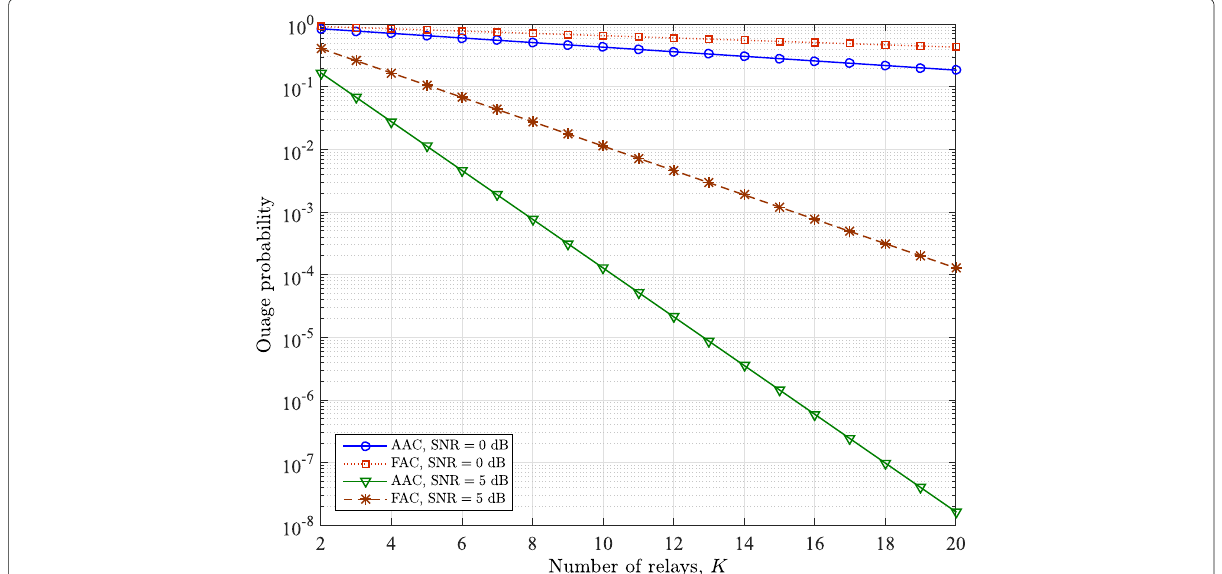
Fig. 7 Outage performance comparison for AAC and FAC versus the number of relays K for different SNR values (0,5 dB) at η =